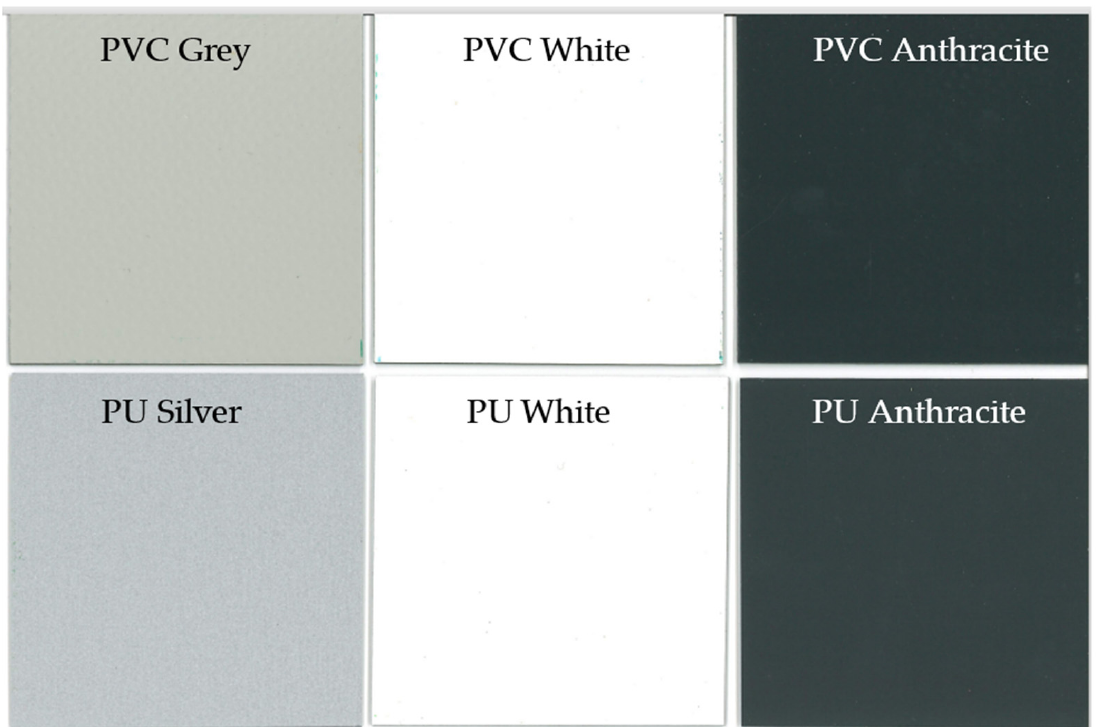
Figure 8. The samples used in this study.